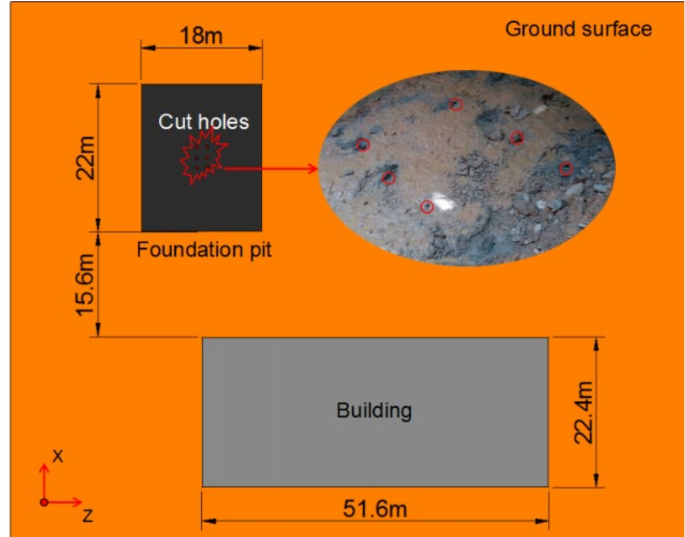
Figure 2. Location plan of high-rise building and foundation pit.